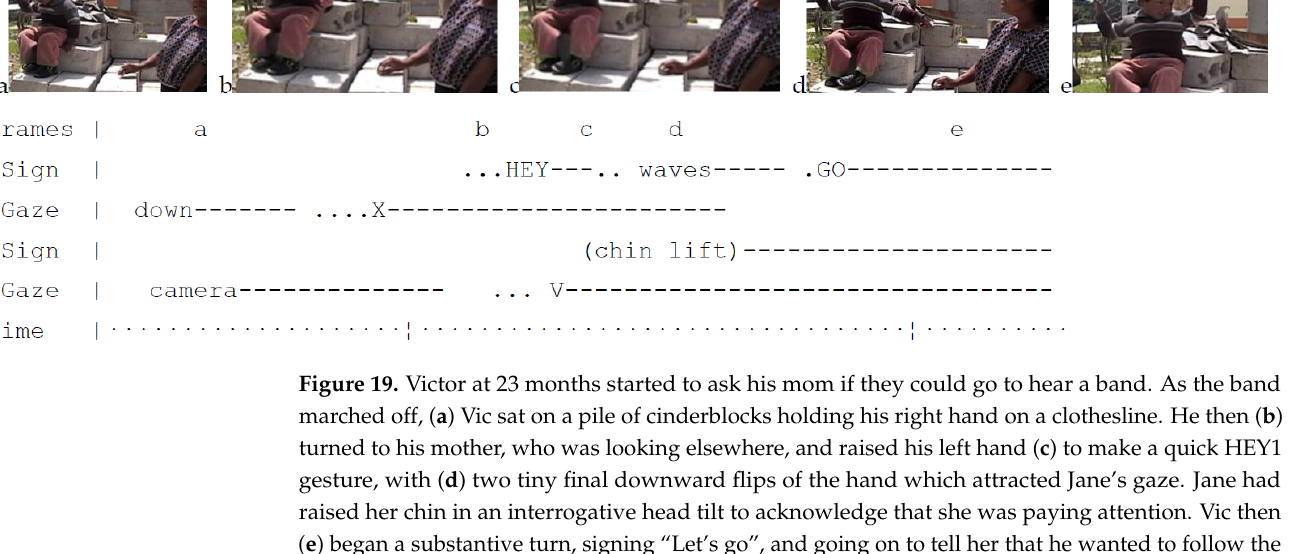
Figure 19. Victor at 23 months started to ask his mom if they could go to hear a band. As the band marched off, ( a ) Vic sat on a pile of cinderblocks holding his right hand on a clothesline. He then ( b ) turned to his mother, who was looking elsewhere, and raised his left hand ( c ) to make a quick HEY1 gesture, with ( d ) two tiny final downward flips of the hand which attracted Jane’s gaze. Jane had raised her chin in an interrogative head tilt to acknowledge that she was paying attention. Vic then ( e ) began a substantive turn, signing “Let’s go”, and going on to tell her that he wanted to follow the band to continue to listen to it.